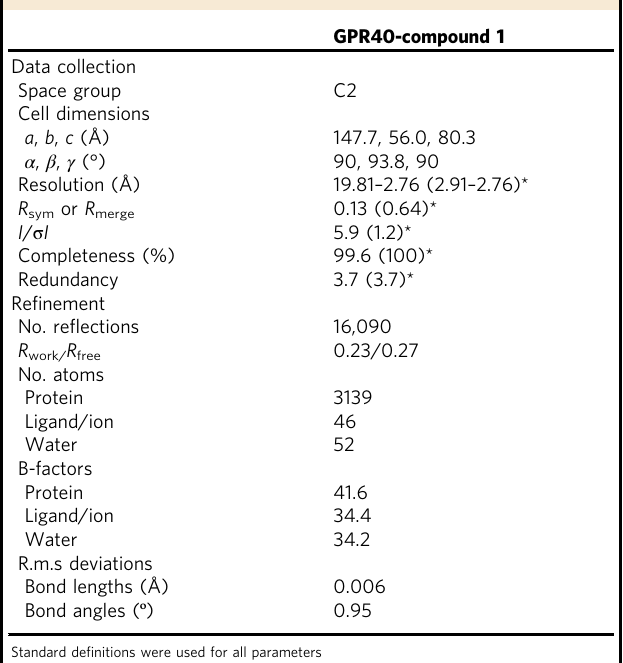
Table 1 Data collection and re fi nement statistics